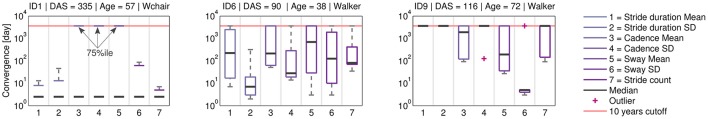
Continuous convergence estimates. Across all patients, variance was observed in the movement parameters. ID1 showed low median CP, suggesting movement parameter convergence between body sides toward discharge. For ID6 and ID9 convergence trends differ by movement parameter. The CP analysis can help to identify patient-specific therapy needs.